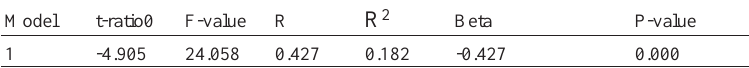
Table 7: Model Summary